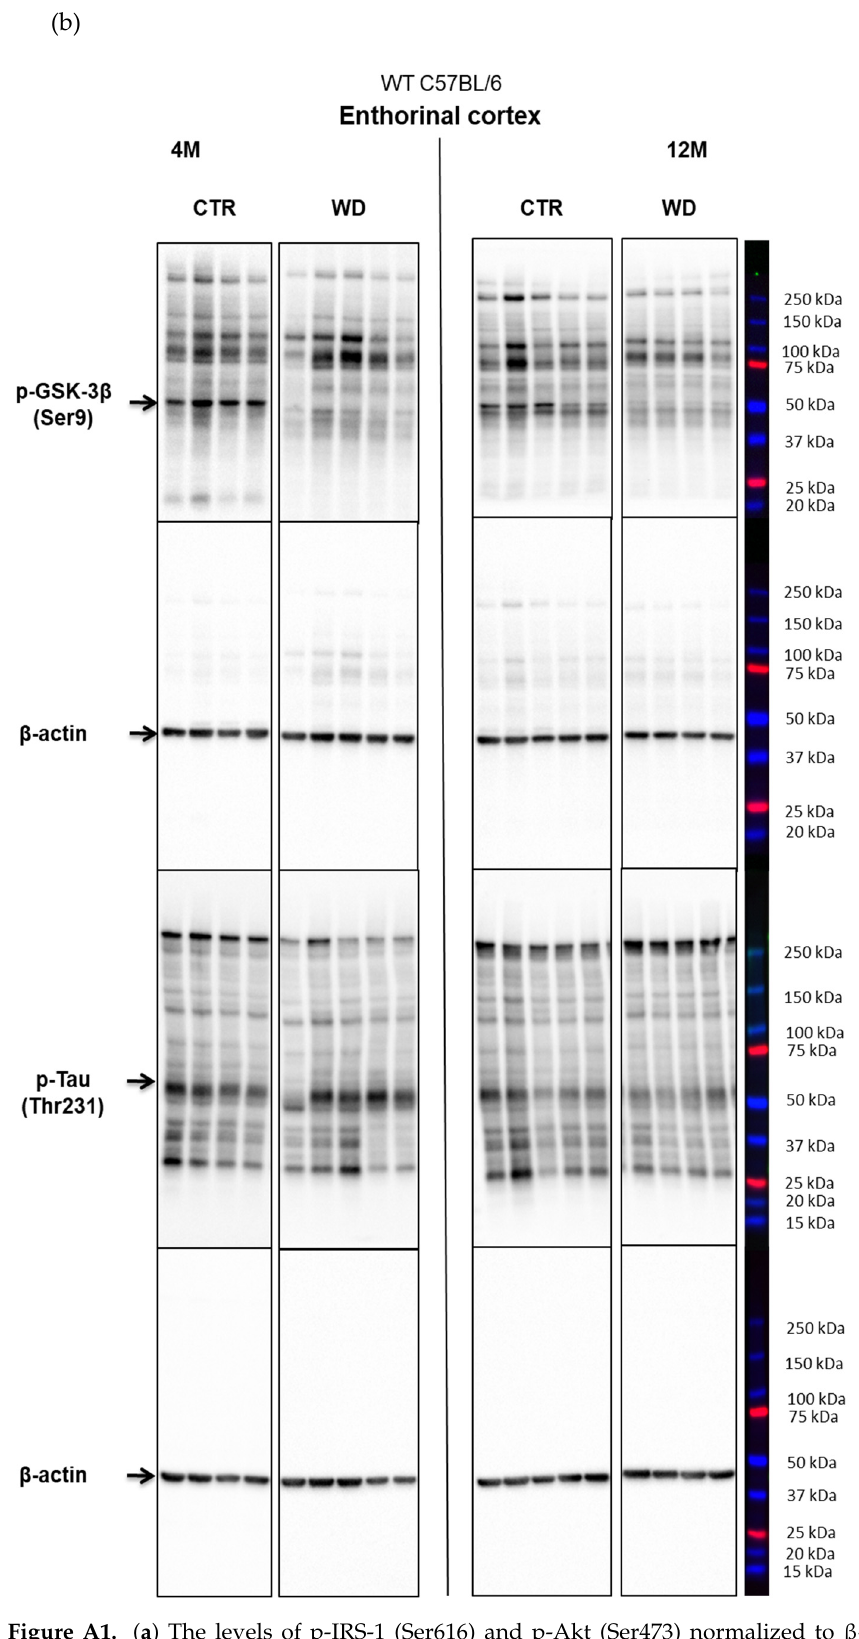
Figure A1. ( a ) The levels of p-IRS-1 (Ser616) and p-Akt (Ser473) normalized to β -actin, in the entorhinal cortex of WT C57BL/6J mice (Section 2.2). ( b ) The levels of p-GSK-3 β (Ser9) and p-Tau (Thr231) normalized to β -actin, in the entorhinal cortex of WT C57BL/6J mice (Section 2.2).